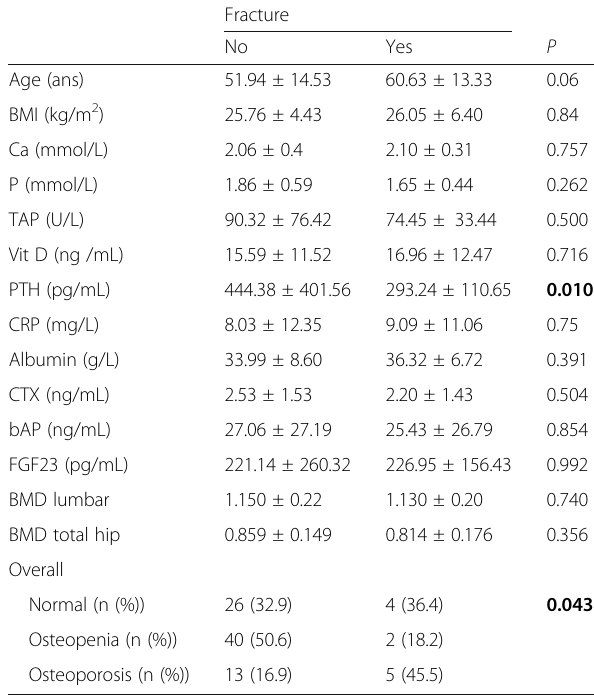
Table 5 Pearson ’ s correlation between clinical, anthropometric, biological and BMD